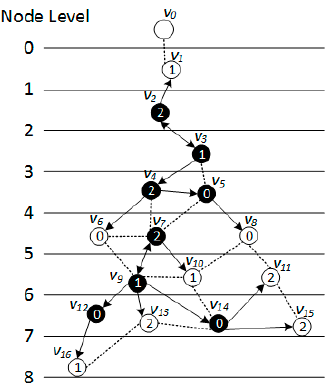
Figure 6. Level-clear figure with minimum for LBAS covering node set.